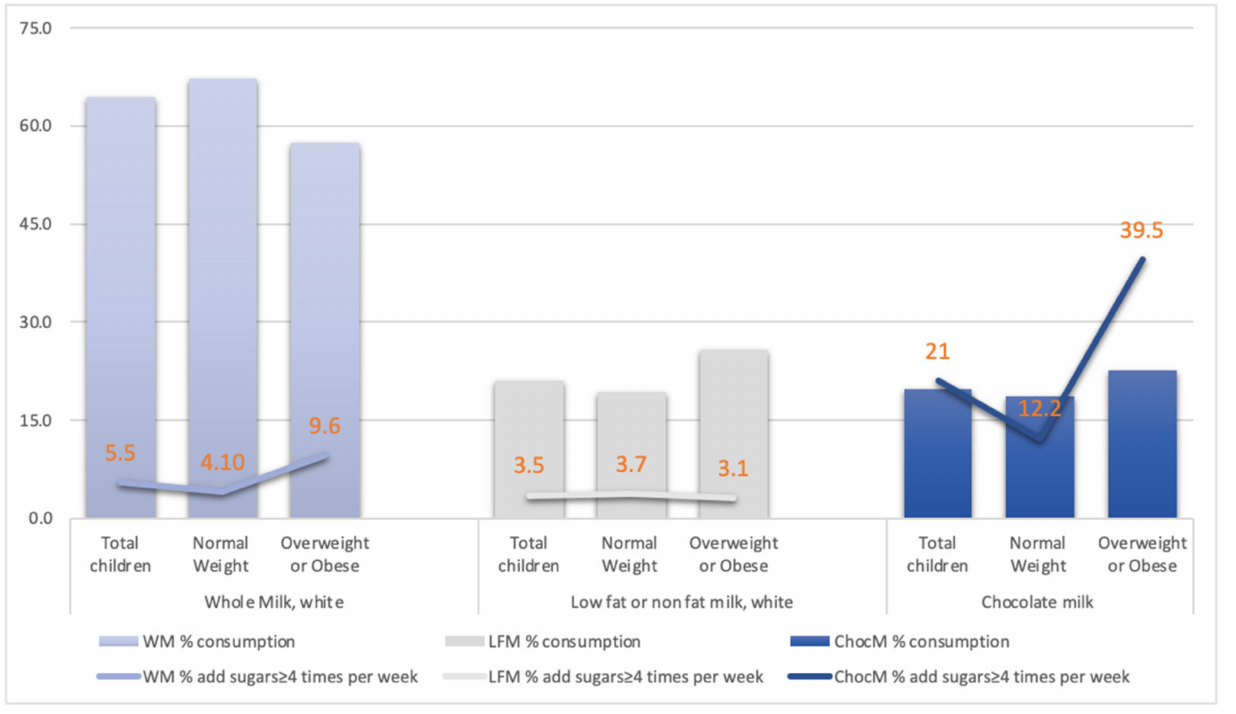
Figure 1. Proportion of children consuming whole, low fat, or chocolate milk in total and by weight status, with the proportion of children adding sugars four or more times per week in each